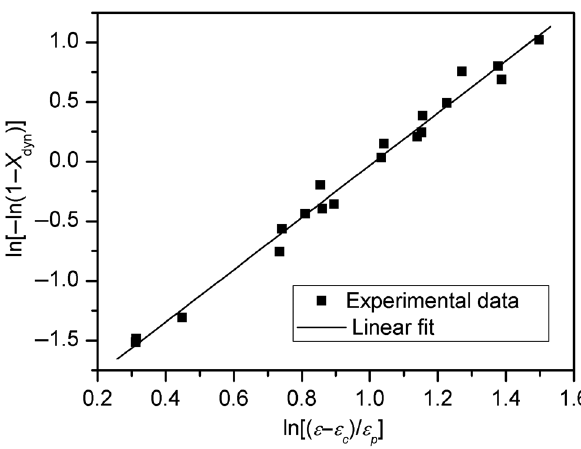
Figure 8: Relationship between ln[ – ln(1 – X dyn )] and ln[( ε – ε c )/ ε p ].